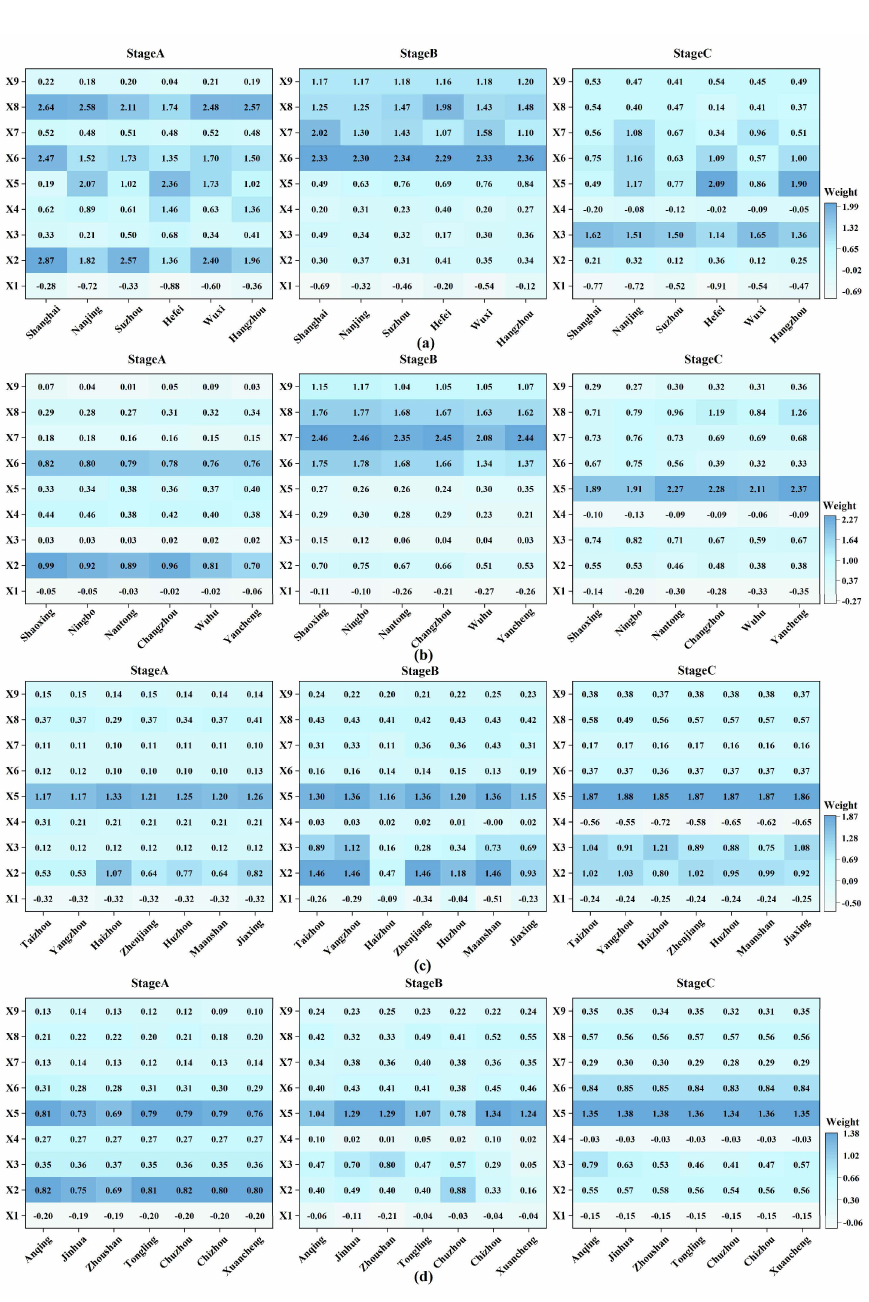
Figure 10. Results of GTWR for each factor in the four types of cities. ( a ) Class I cities, ( b ) Class II cities, ( c ) Class III cities, ( d ) Class IV